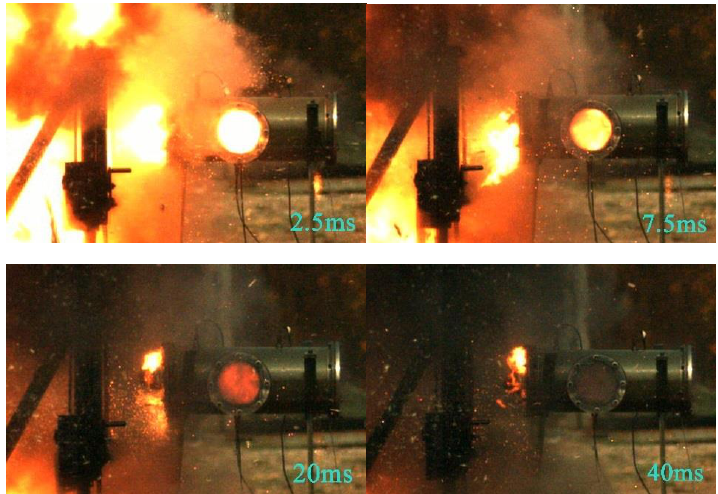
Figure 14. High-speed video of experiment No. 6 with a violent reaction.